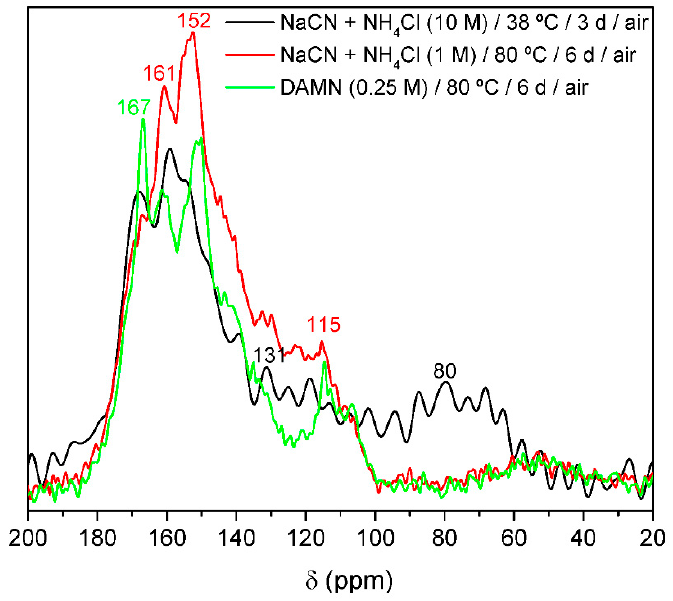
Figure 6. Cross-polarization magic angle spin (CPMAS) 13 C Nuclear Magnetic Resonance (NMR) spectra of several HCN-derived polymers synthesized using water as the solvent.